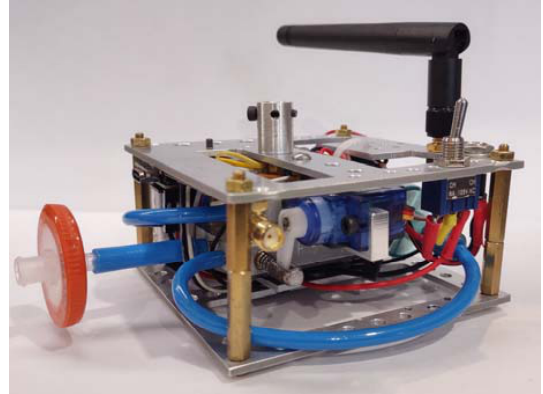
Figure 2. The view of the gas sensing platform.